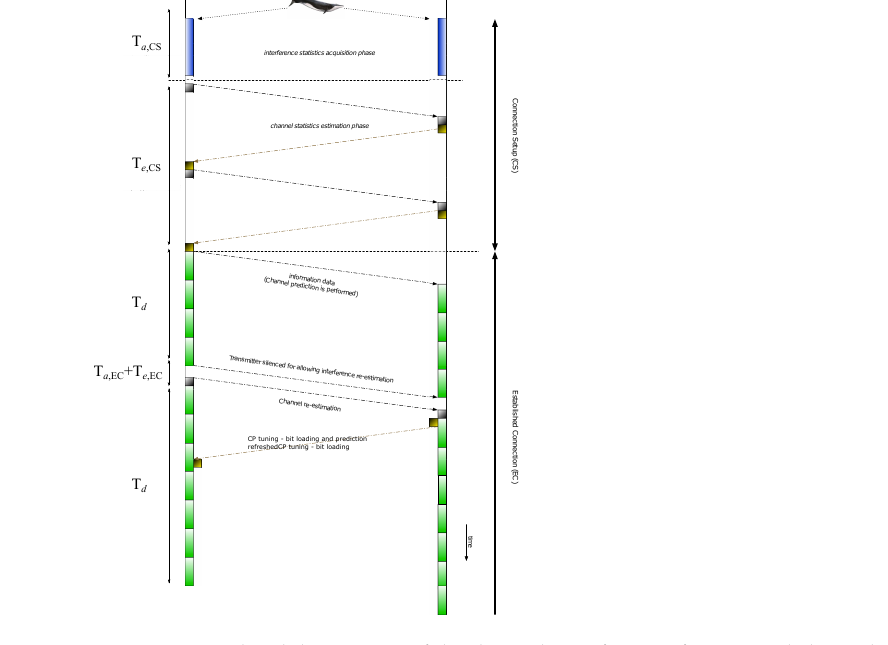
Figure 1. Graphical description of the three phases for interference and channel estimation and data transmission/detection during CS and